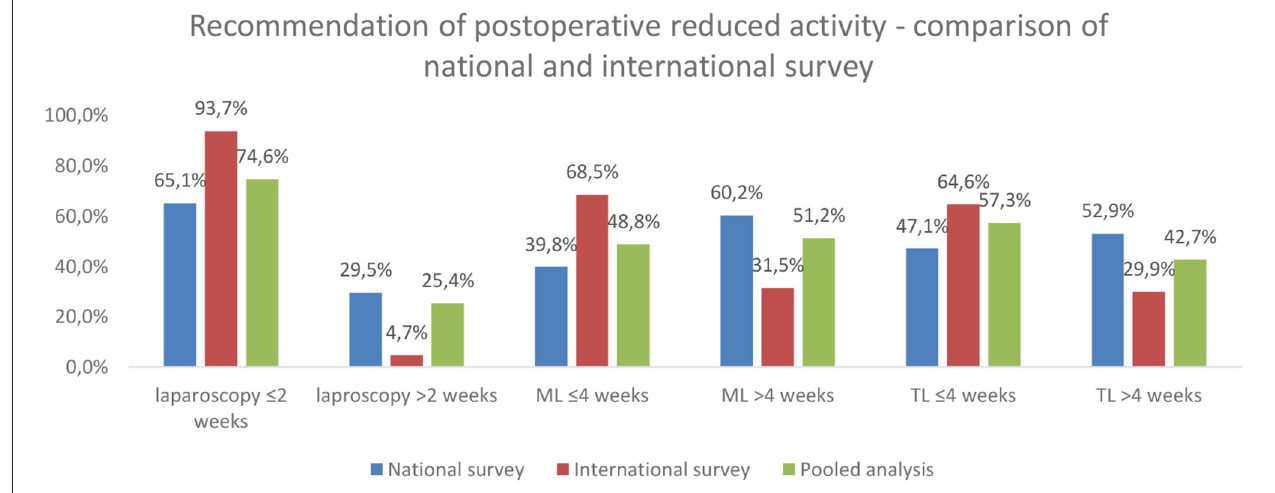
FIGURE 5 | Comparison of survey results. The differences were statistically significant ( p = 0.000; chi-squared